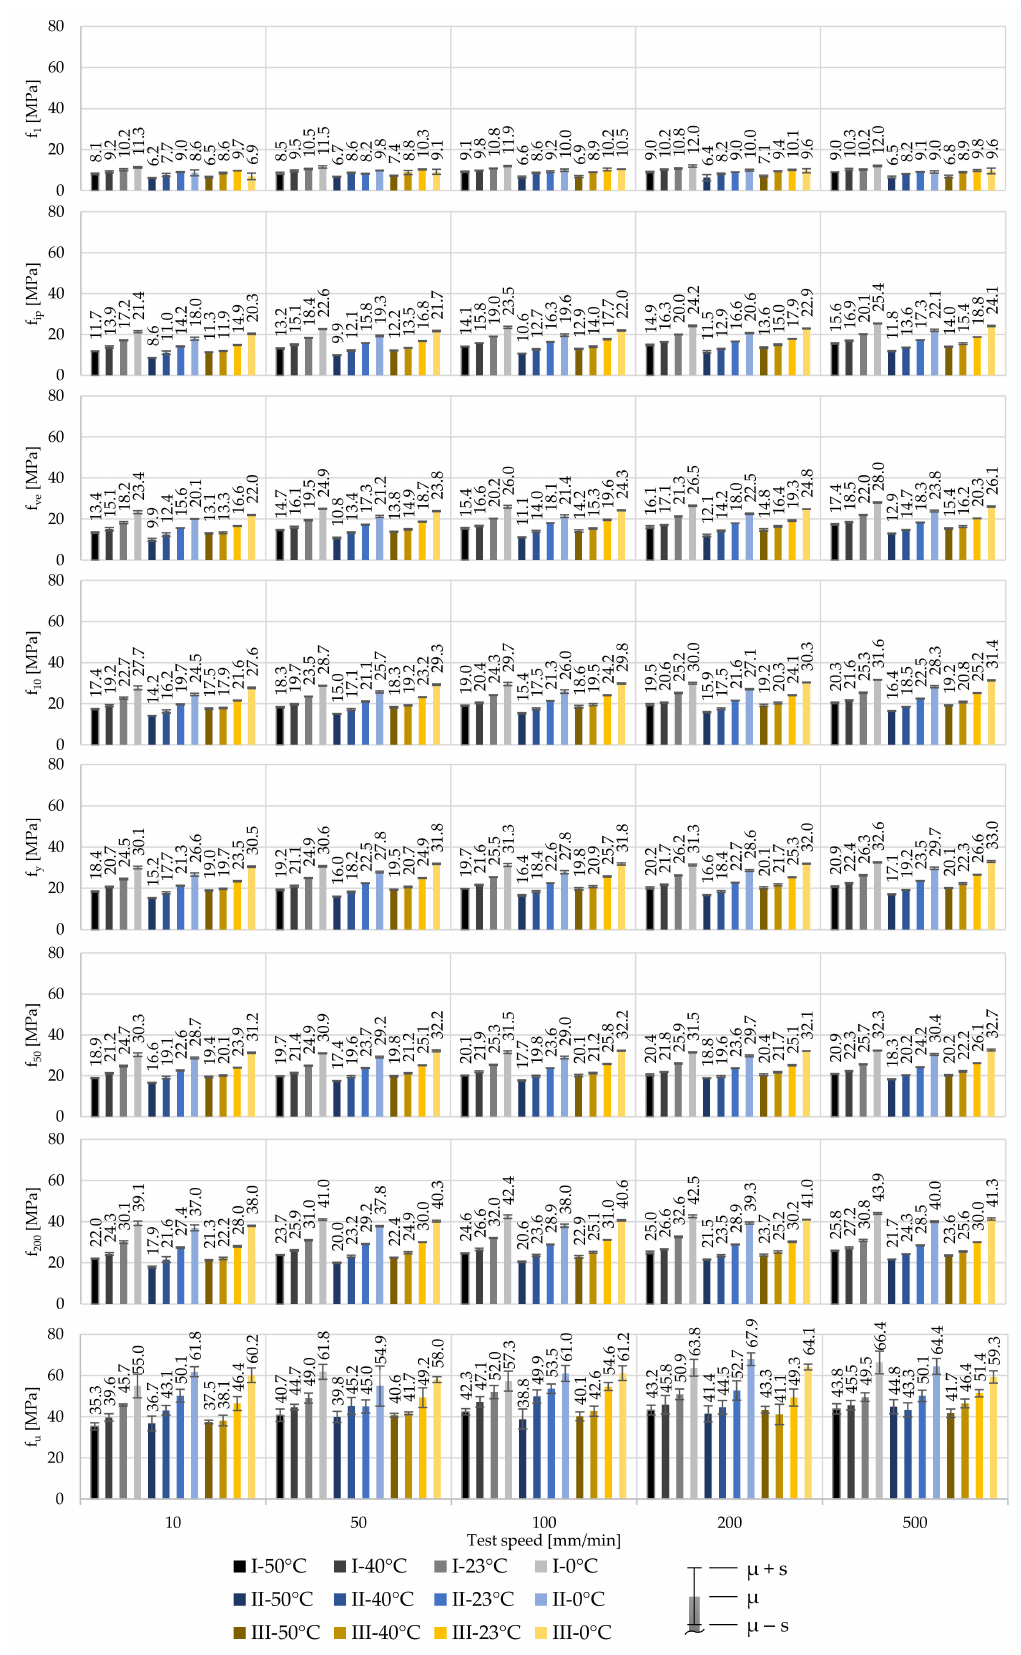
Figure 5. Influence of the test temperature and test speed on the stress at specific strains for 250 µ m ETFE foils of producers I, II, and III as mean